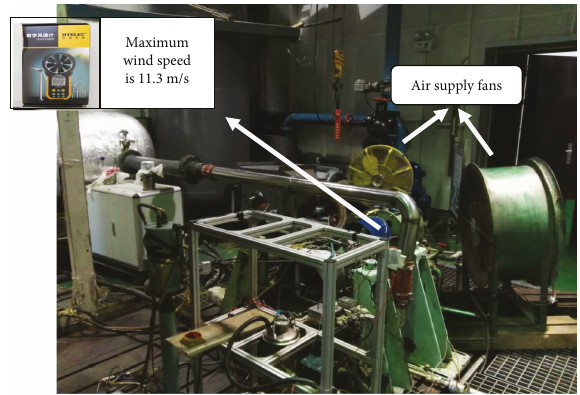
Figure 6: Cooling air condition simulation bench at high